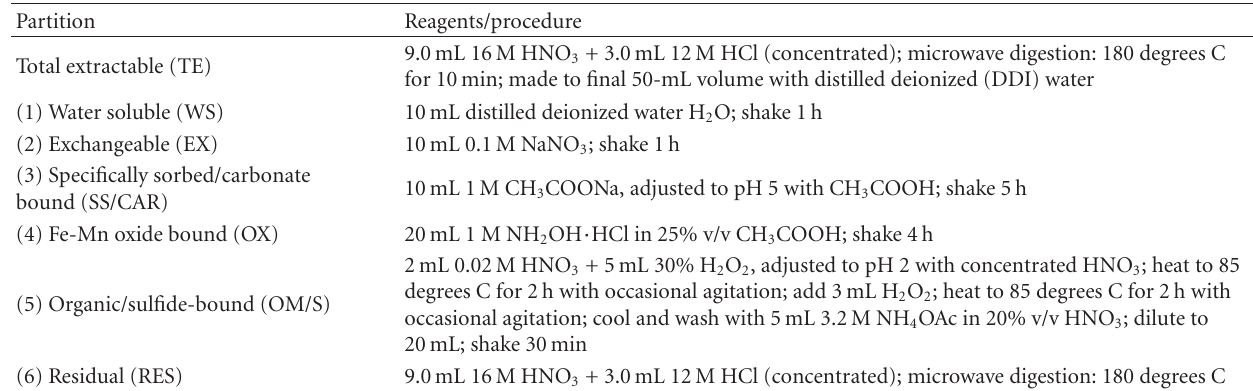
Table 3: Designated partition and chemical reagents used for total extractable and sequential extractions a